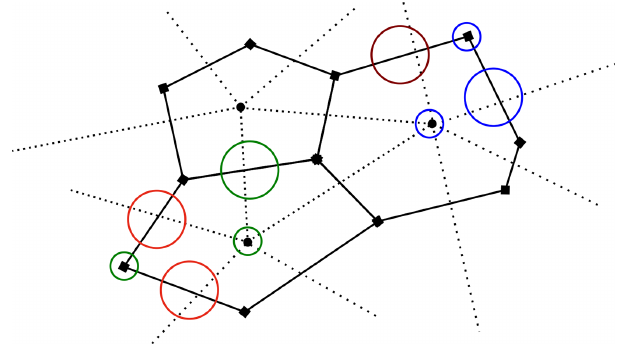
Figure 5. A diagram of the stencil EVE (v,e,i) = EC (i) ∩ EV (v) − e . Consider the set (v,e,i) denoted in green; note that EVE (v,e,i) are the two red edges. Now consider the set (v,e,i) denoted in blue: then EVE (v,e,i) is the brown